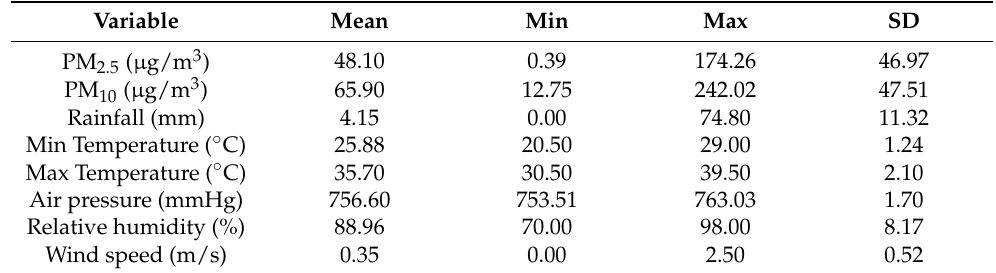
Table 3. Summary statistics of PM 2.5 and PM 10 mass concentration and meteorological parameters in Pathum Thani during the sampling period from 18 February to 14 September